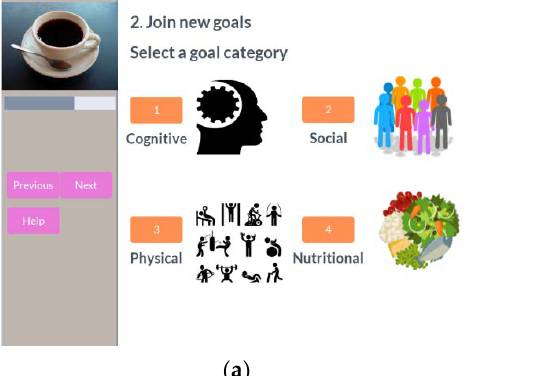
Figure 12. Join goal in coffee session. ( a ) Select goal category; ( b ) select goal in category.